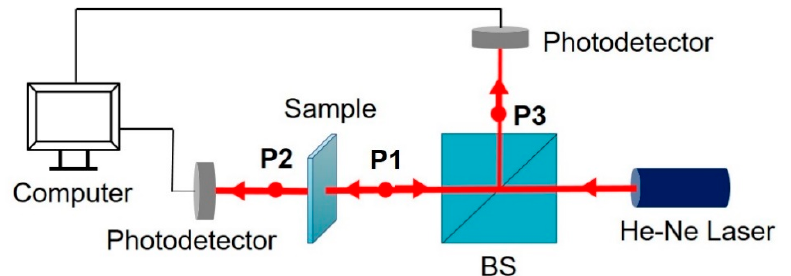
Figure 2. Schematic of the setup for measuring optical transmittance and reflectance for the thin-film metallic glass (TFMG).